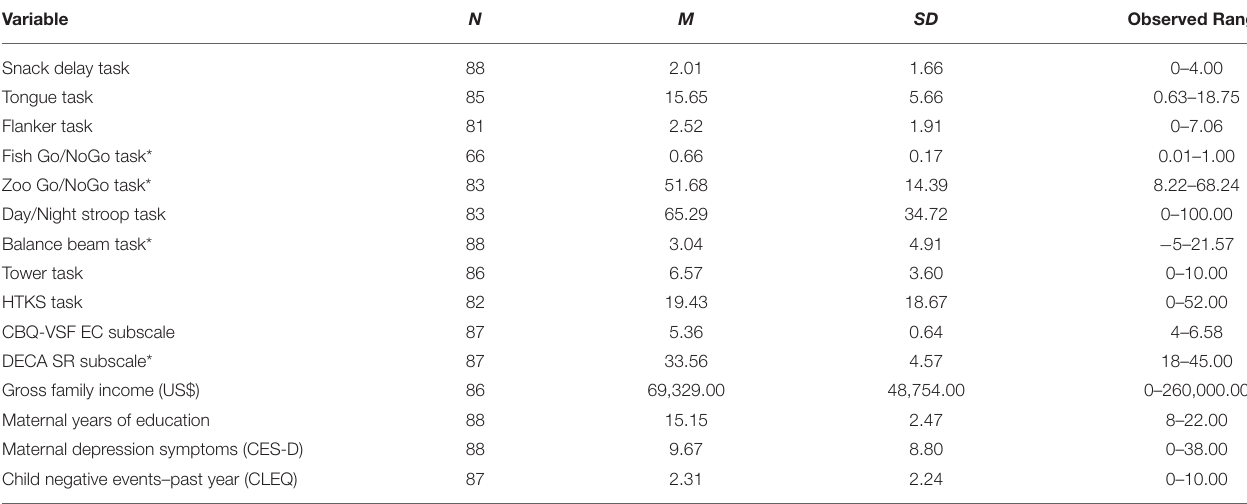
TABLE 2 | Descriptive data of self-regulation and family environment variables.